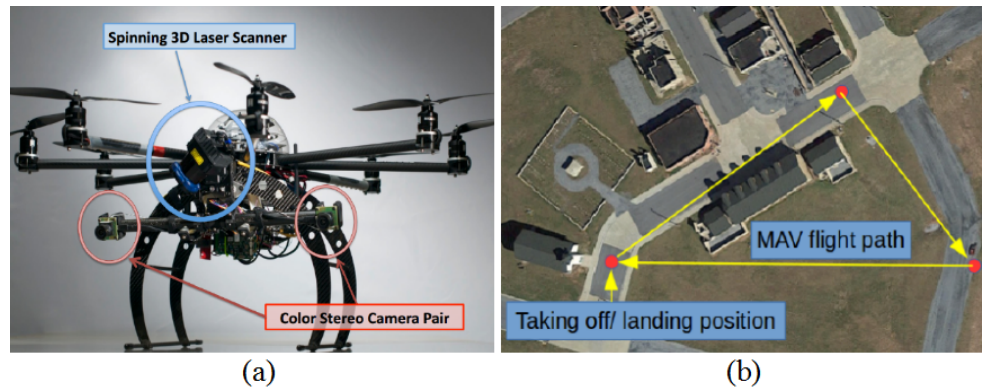
Figure 9. Our MAV for the dataset recording and experimental environment. ( a ) MAV developed by our team for the state estimation experiments; ( b ) experimental scenario from Google Earth and the schematic flight trajectory for the MAV.